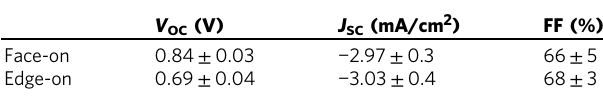
Table 1 Solar cell characteristics of p-SIDT(FBTTh 2 ) 2 /C 60 devices with face-on or edge-on donor molecular